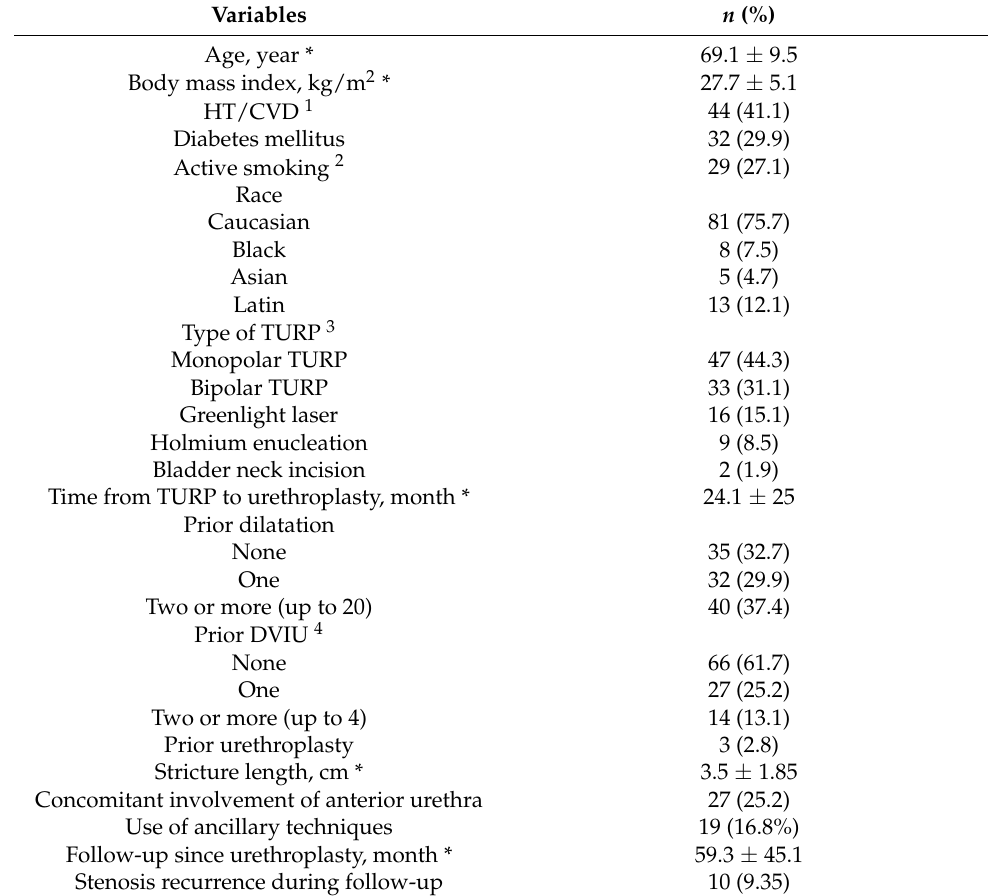
Table 1. Characteristics of the patients included in the study ( n = 107). * Mean ± SD; 1 HT/CVD, hypertension and/or cardiovascular disease; 2 Smoking includes tobacco chewing habit; 3 TURP, transurethral resection of the prostate; 4 DVIU, direct vision internal